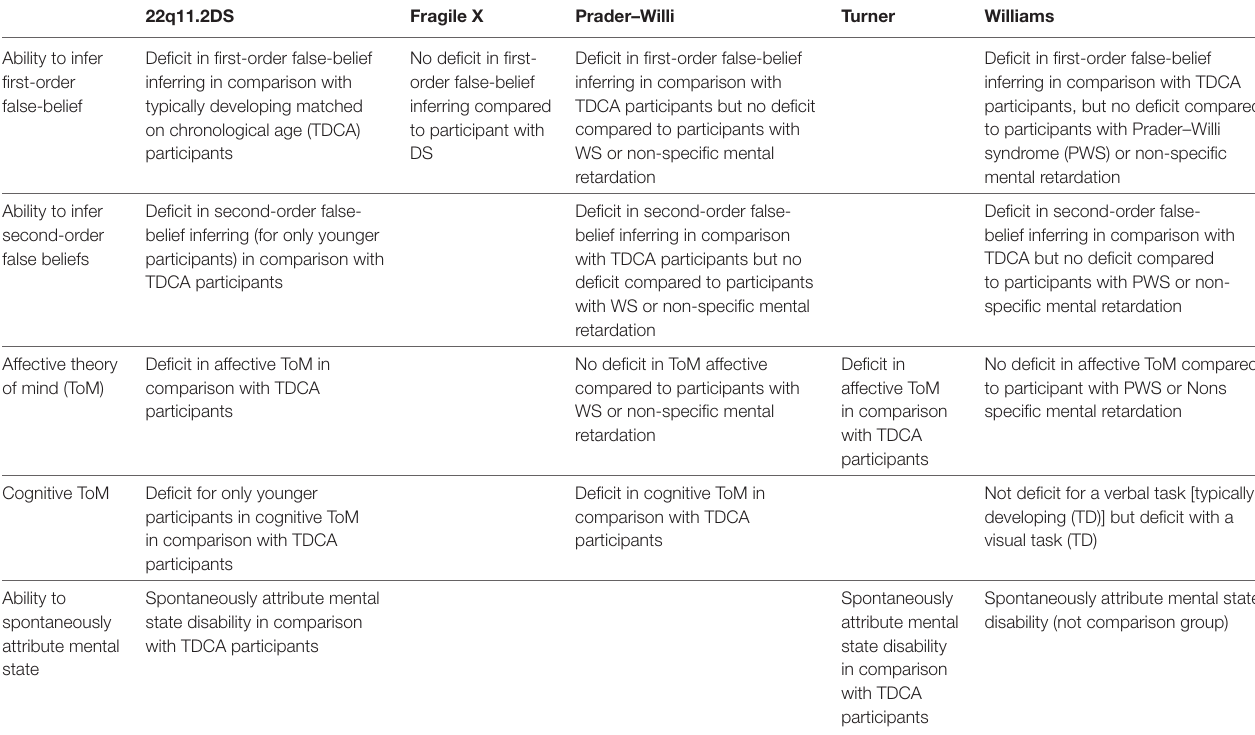
TAbLe 7 | Theory of mind among rare neurodevelopmental